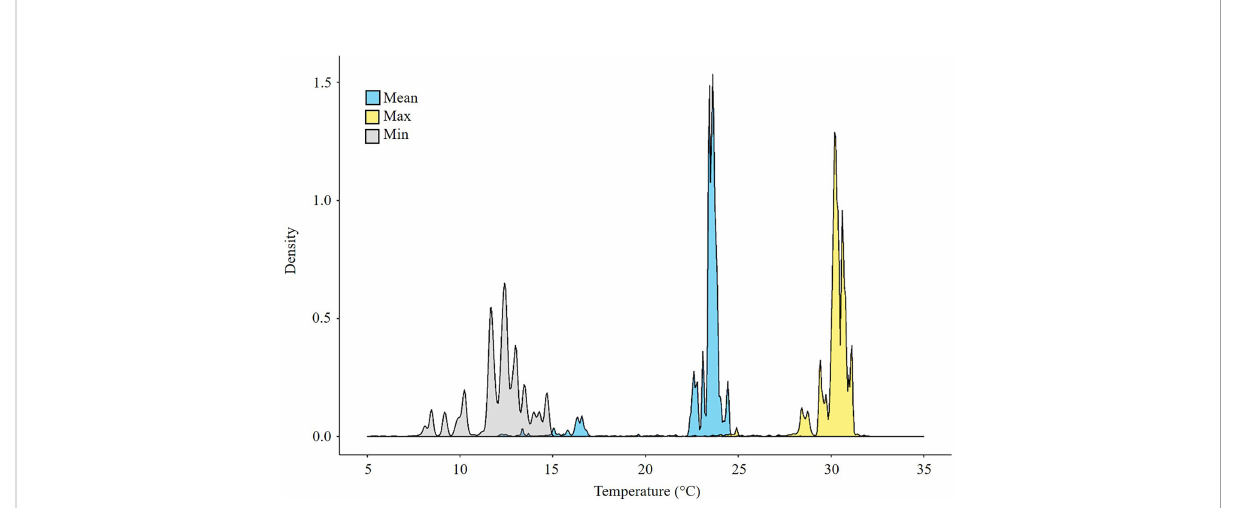
FIGURE 1 Density of Callinectes sapidus occurrences as a function of temperature (minimum, maximum, mean). Number of = 52 323